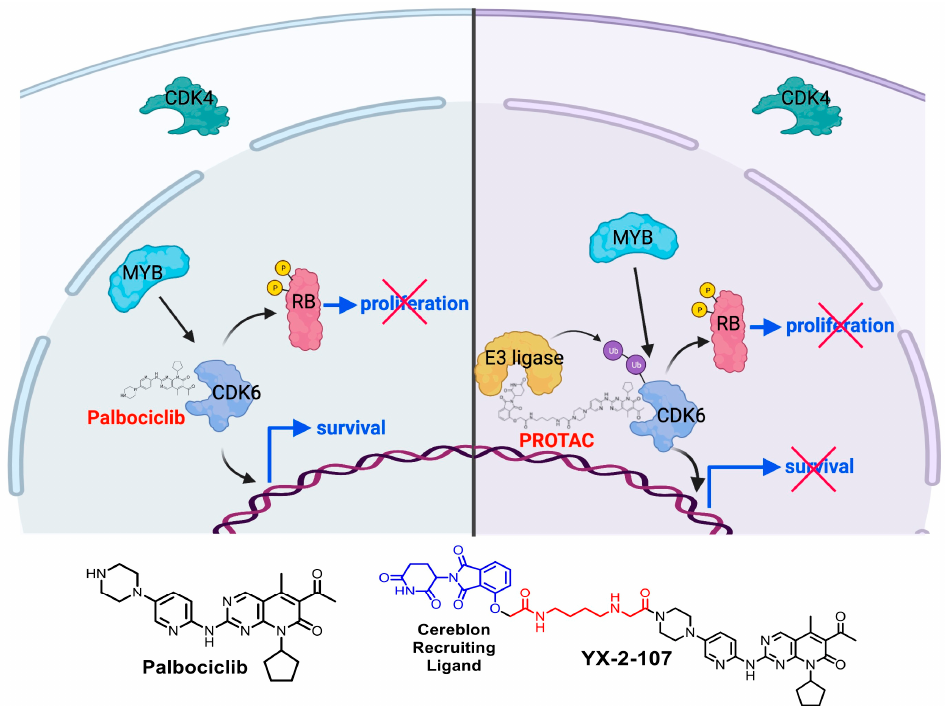
Figure 3. Inhibition of CDK6 activity in Ph+ ALL. Growth of Ph + ALL cell lines and primary cells is dependent on MYB-dependent transcriptional regulation of CDK6. CDK6 is a key cell cycle regulator predominantly localized in the nucleus of Ph+ ALL cells. Pharmacologic inhibition of CDK6 can be achieved with the kinase inhibitor Palbociclib (left). This results in suppression of leukemic cell proliferation but does not affect the kinase-independent function of CDK6. CDK6-targeted proteolysis-targeting chimeras (PROTACs; YX-2-107, right) are molecules comprising a ligand for the protein of interest and an E3 ligase–recruiting ligand that are connected by a linker, allowing recruitment of E3 ligases for optimal ubiquitination and proteasomal degradation. YX-2-107 promotes the rapid and preferential degradation of CDK6 over CDK4 in Ph+ ALL cells, suppressing the proliferation and survival of de novo or TKI-resistant primary Ph+ ALL cells. CDK6 degradation suppresses Ph + ALL more effectively than CDK4/6 inhibition, due to suppression of kinase-dependent and independent effects of CDK6. Image created with BioRender.com (2020).